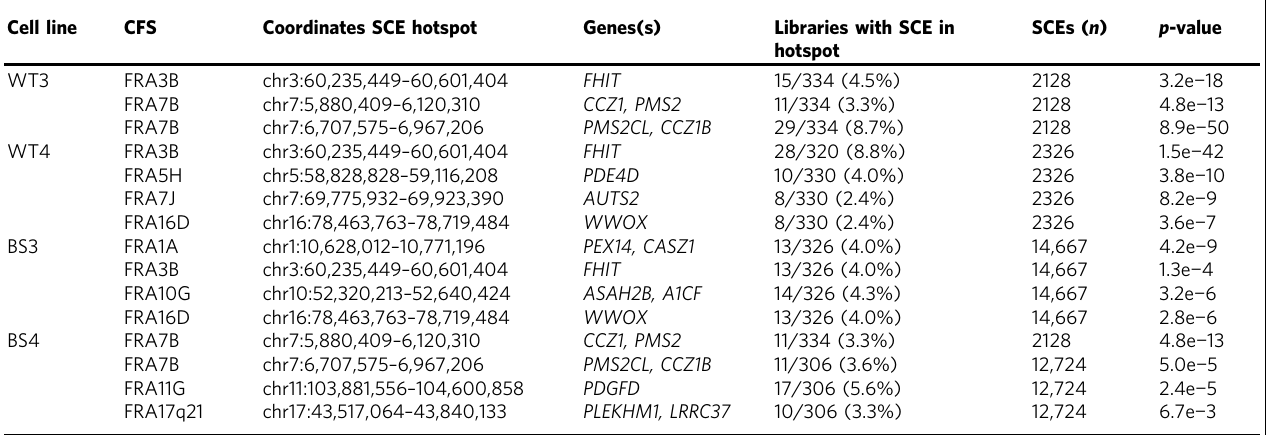
Fig. 1 High-resolution mapping of SCEs and common fragile site hotspots. a , b Representative Strand-seq libraries generated from a a WT fi broblast and b a BS fi broblast. Mapped DNA template strand reads are plotted on directional chromosome ideograms; reads mapping to the Crick (positive) strand of the reference genome are shown in green, those mapping to the Watson (negative) strand are shown in orange. SCEs are identi fi ed as a switch in template strand state, indicated by arrowheads. c , d Number of SCEs detected during a single cell cycle in c primary fi broblasts and d EBV-transformed B- lymphocytes obtained from healthy donor and BS patients. Each grey point represents number of SCEs detected in a single-cell Strand-seq library, red lines indicate mean ± SD. p -values were calculated using ANOVA. e SCE mapping resolutions across all eight cell lines. Lines represent percentage of the total number of SCEs mapped at resolutions below indicated values. f , g Correlations between average numbers of SCEs/chromosome/library and chromosome size for f WT and g BS cells. R 2 -values are color-matched to the cell lines. h Example of SCE hotspot detected within FRA3B ( FHIT ). Mapped SCE regions for each cell line were uploaded onto the UCSC Genome Browser. Black bars represent genomic locations of SCE regions; size indicates mapping resolution using the BAIT program. Red box indicates the location of the SCE hotspot as detected by